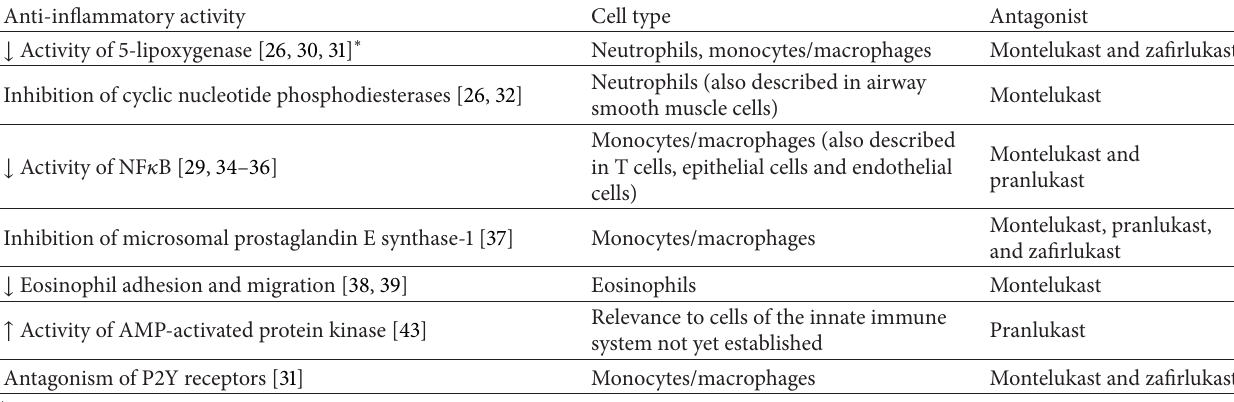
Table 2: Cysteinyl leukotriene receptor-1-independent anti-inflammatory activities of montelukast, pranlukast, and